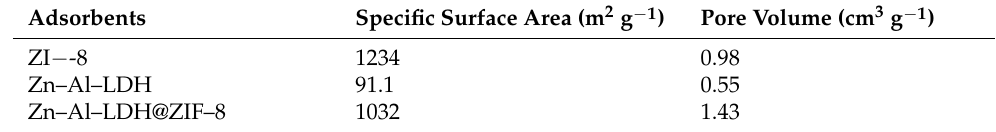
Table 2. Porosity characteristics of Zn–Al–LDH, ZIF–8, and Zn–Al–LDH@ZIF–8 nanocomposites. Adsorbents